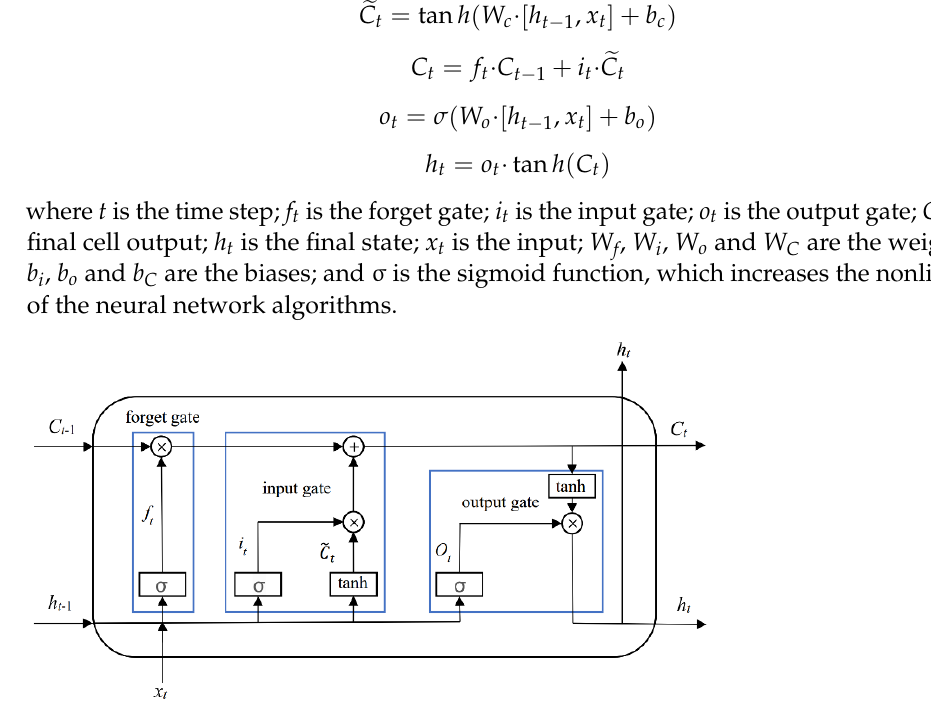
Figure 1. Schematic representation of the LSTM memory cell.